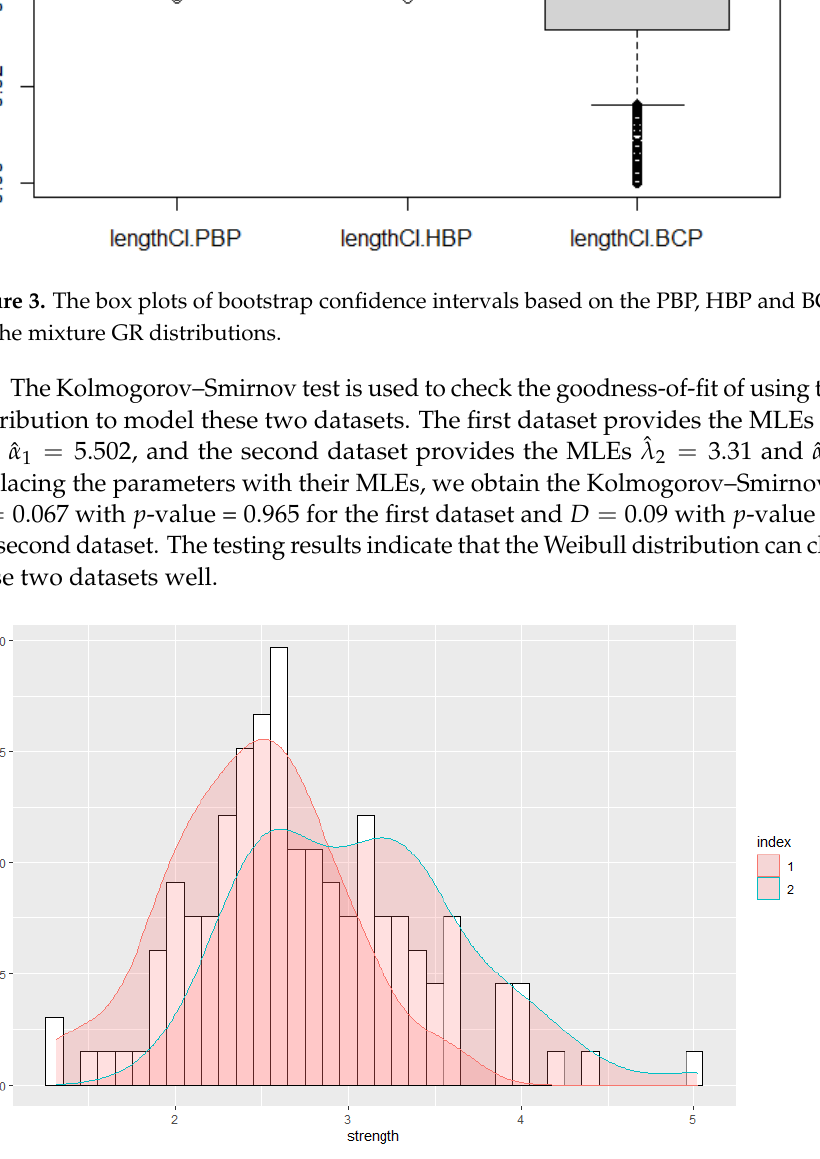
Figure 4. The histograms and empirical density plots of the strength of carbon fibers from the two datasets in Table